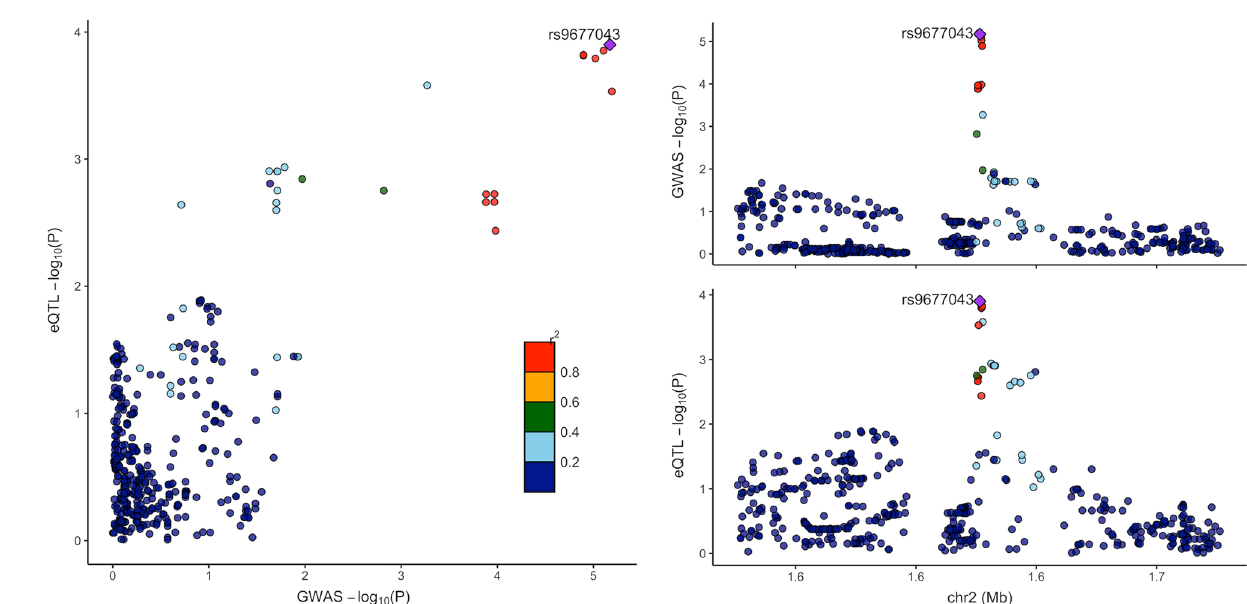
Figure 4. Regional plots of GWAS and eQTL signals on MYT1L gene in retina. Variants are colored based on their correlation with the labeled top variant, which has the smallest p value in the